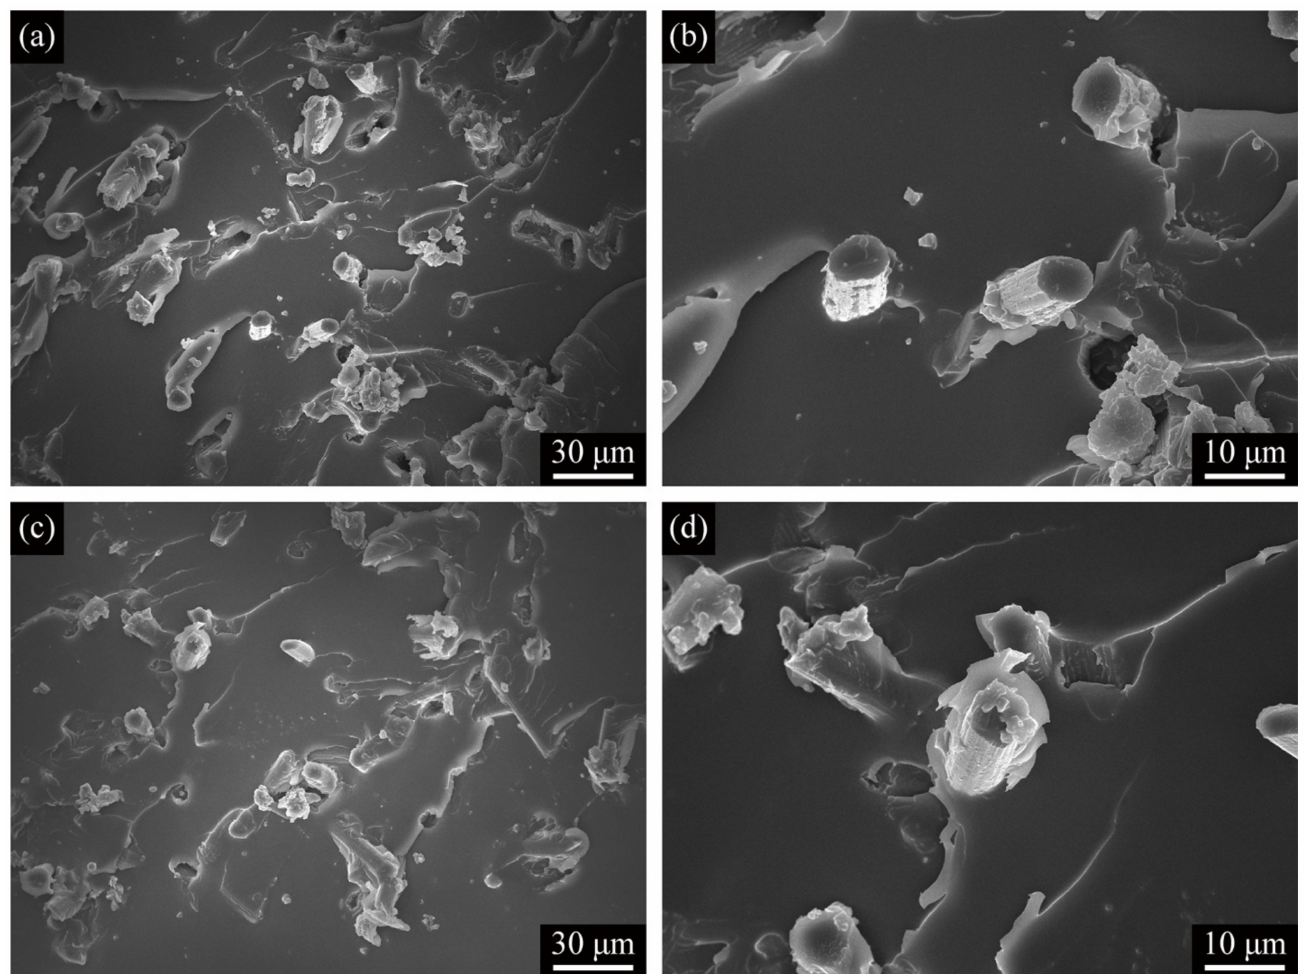
Figure 7. ( a ) Low-magnification and ( b ) high-magnification SEM images of SENB flexural fracture surfaces of C2/epoxy; ( c ) Low-magnification and ( d ) high-magnification SEM images of SENB flexural fracture surfaces of